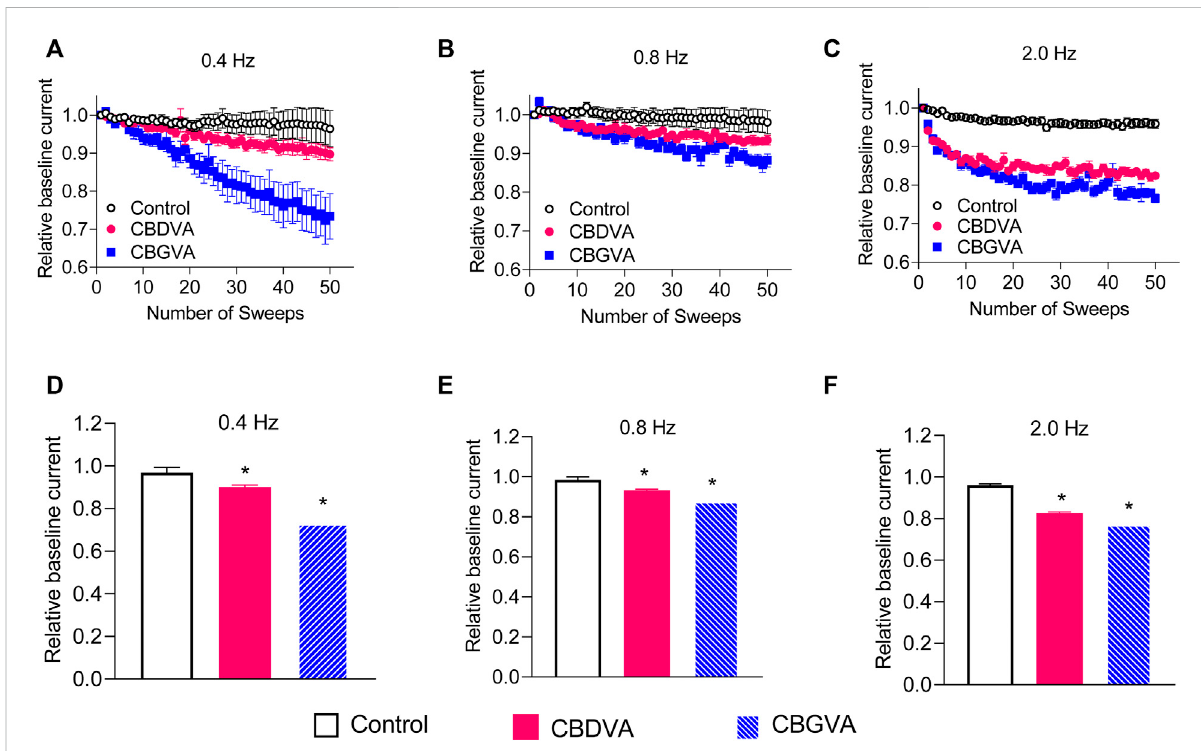
FIGURE 3 CBGVAandCBDVAblockCav3.1channelsinafrequency-dependentmanner.Intheabsence(control)orpresenceof5 µMCBGVAandCBDVA, cells were held at − 100 mV and stepped at three different frequencies (A) 0.4 Hz (B) 0.8 Hz, (C) 2.0 Hz to − 30 mV with intersweep holding potential of − 100 mV. Data presented are mean ± SEM of peak currents of each sweep after normalisation to the average peak current of thebaseline sweeps ( fi rst three sweeps) in 5 – 11 cells. Summary data of therelative current of CBDVA and CBGVA at (D) 0.4 Hz, (E) 0.8 Hz (F) 2.0 Hz. Data presented are mean ± SEM of the last three sweeps in 5 – 11 cells. Statistical analysis was performed using a student t-test with * denoting p <